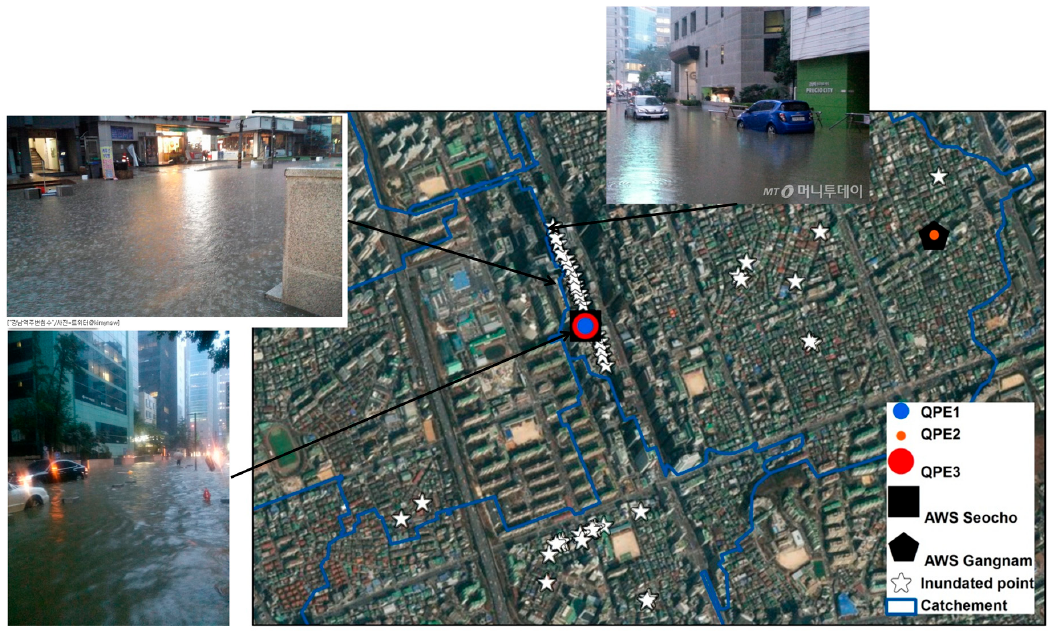
Figure 9. Locations where real flooding occurred and locations of maximum simulated total flood volume according to the type of QPE product. Table 4. Simulated node flooding results using Storm Water Management Model (SWMM) for 22 July 2013.